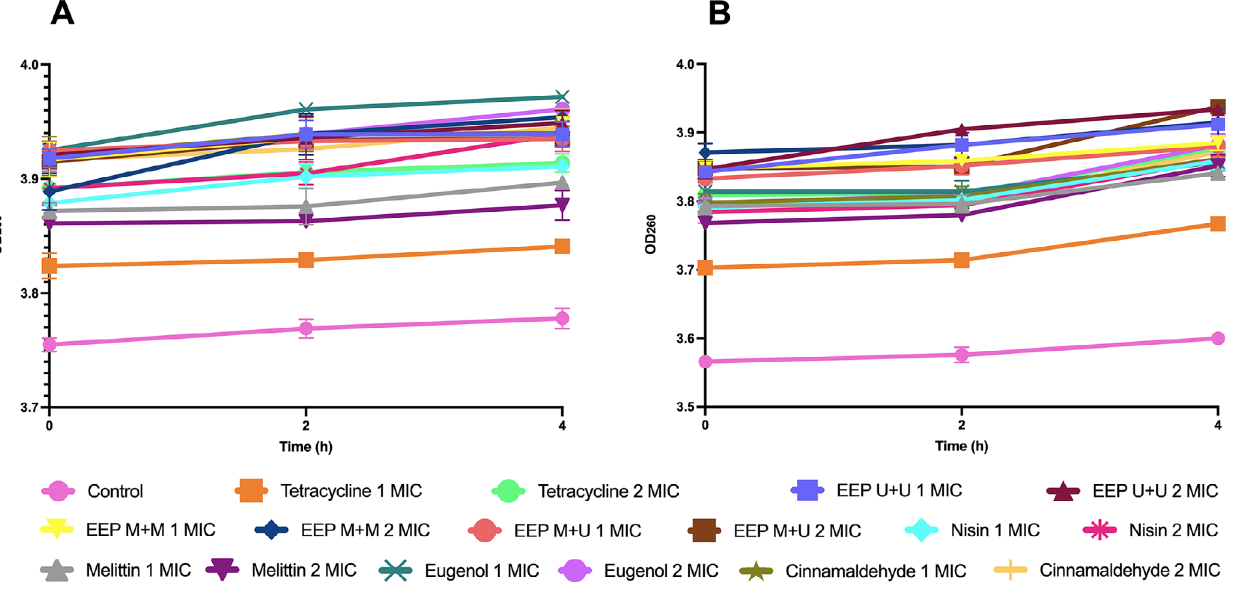
Figure 6. Absorbable cellular constituents at 260 nm released from (A) B. subtilis and (B) P. alvei after treatment with tested products at concentrations of 1 and 2